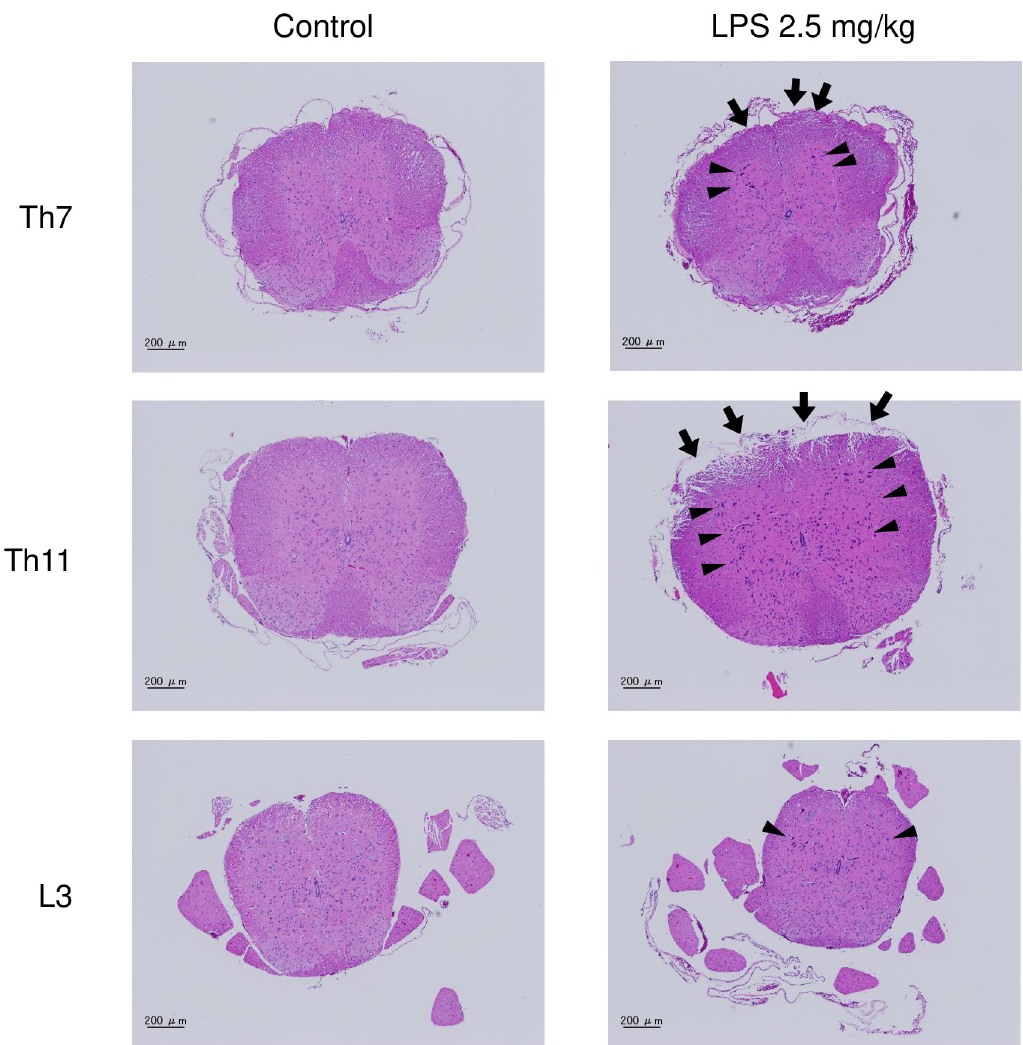
Fig 3. Histological changes in spinal cords after intraperitoneal LPS administration. LPS 2.5 mg/kg, or the same amount of normal saline, was intraperitoneally administrated to 10-week-old BALB/c male mice. The spinal cords were harvested 1 and 3 days after the administration, and Th 7, Th 11, and L3 transverse spinal sections were prepared and stained with hematoxylin and eosin (n = 4). A representative image of saline administrated mice was shown as control. Arrows indicate edematous changes of the anterior column and arrowheads depict densely stained cells. Scale bars, 200 μ m ( ×